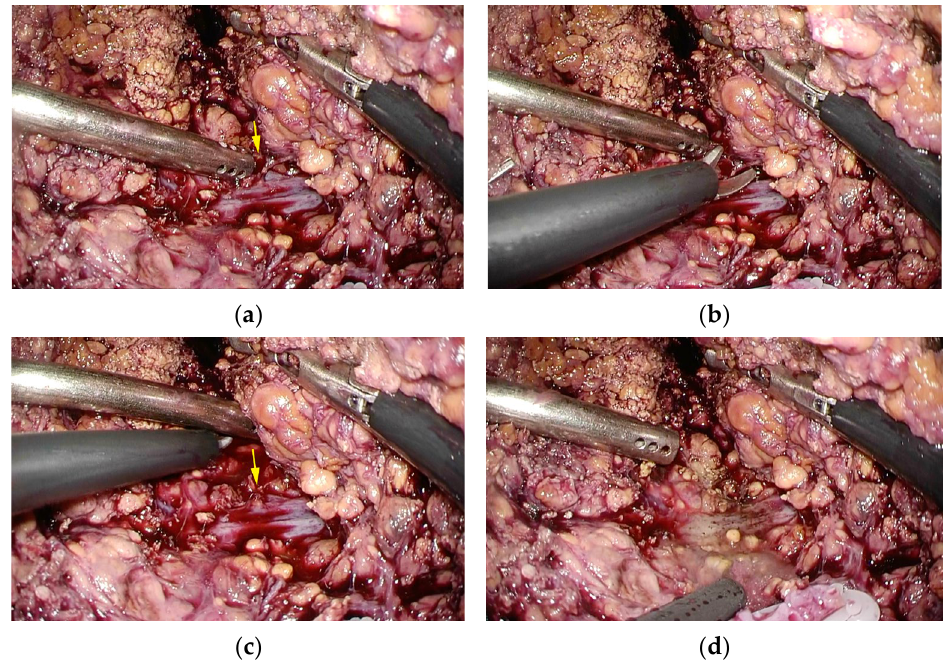
Figure 3. ( a ) The small crotch formed teared from vessels. The yellow arrow is the hangnail injury. ( b ) Sharply cutting the small branch teared from vessels. ( c ) Releasing the tension against the vessels. The yellow arrow is the hangnail injury. ( d ) The hemostasis using a saline dripping monopolar soft-coagulation system.